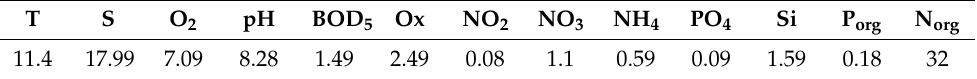
Table 2. Mean characteristics of seawater at the sampling site in April–May 2017: temperature T ( ◦